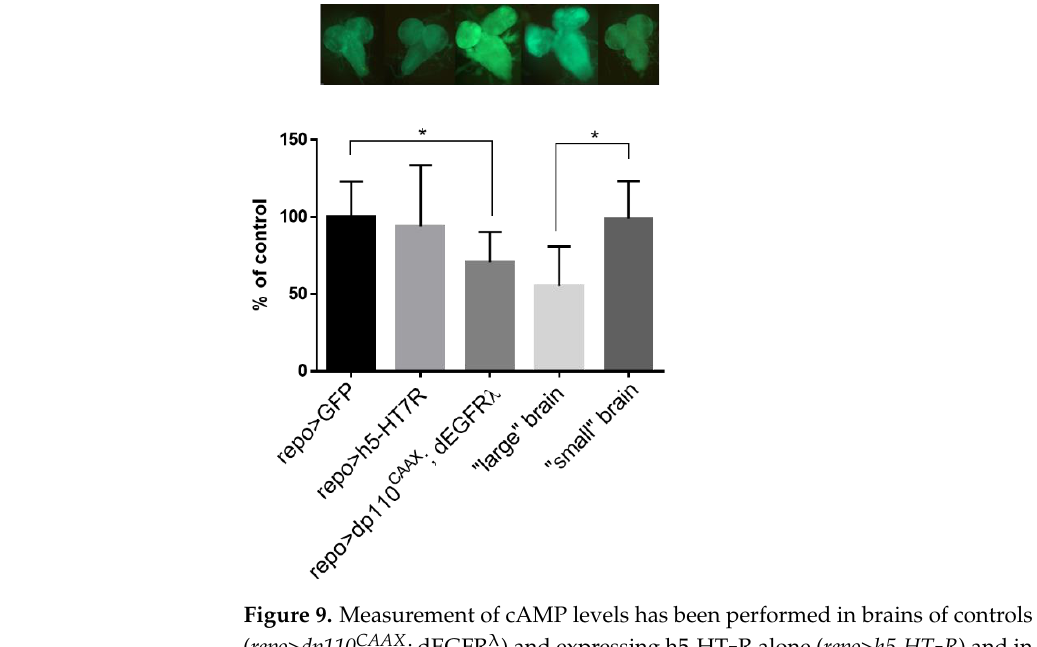
Figure 9. Measurement of cAMP levels has been performed in brains of controls (repo>GFP), glioma (repo>dp110 CAAX ; dEGFR λ ) and expressing h5-HT7R alone (repo>h5-HT7R) and in “small” and “large” brains (repo>dp110 CAAX ; h5-HT7R; dEGFR λ ). Values have been normalized with the concen- tration of proteins detected in each sample and expressed as a percentage of control. The upper panel represents images of fluorescent brains for each associated condition and observed by fluo- rescence microscopy. *, p < 0.05. Statistical analysis was done by one-way ANOVA using Tukey’s multiple comparison test, N = 8